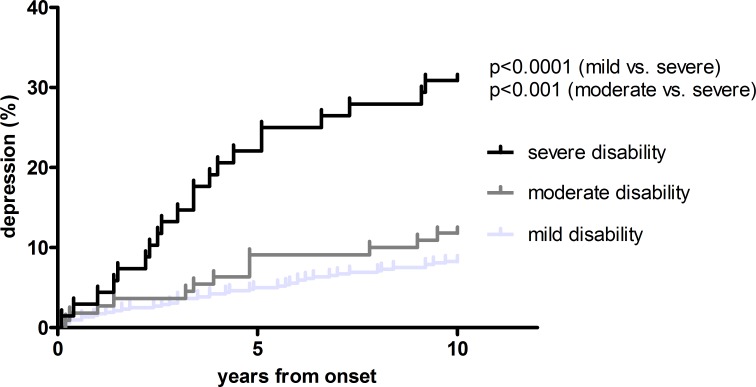
time to depression.Kaplan-Meier curves of the risk of developing depression according to disability status 10 years after onset. Log rank test used for calculation of significancy.